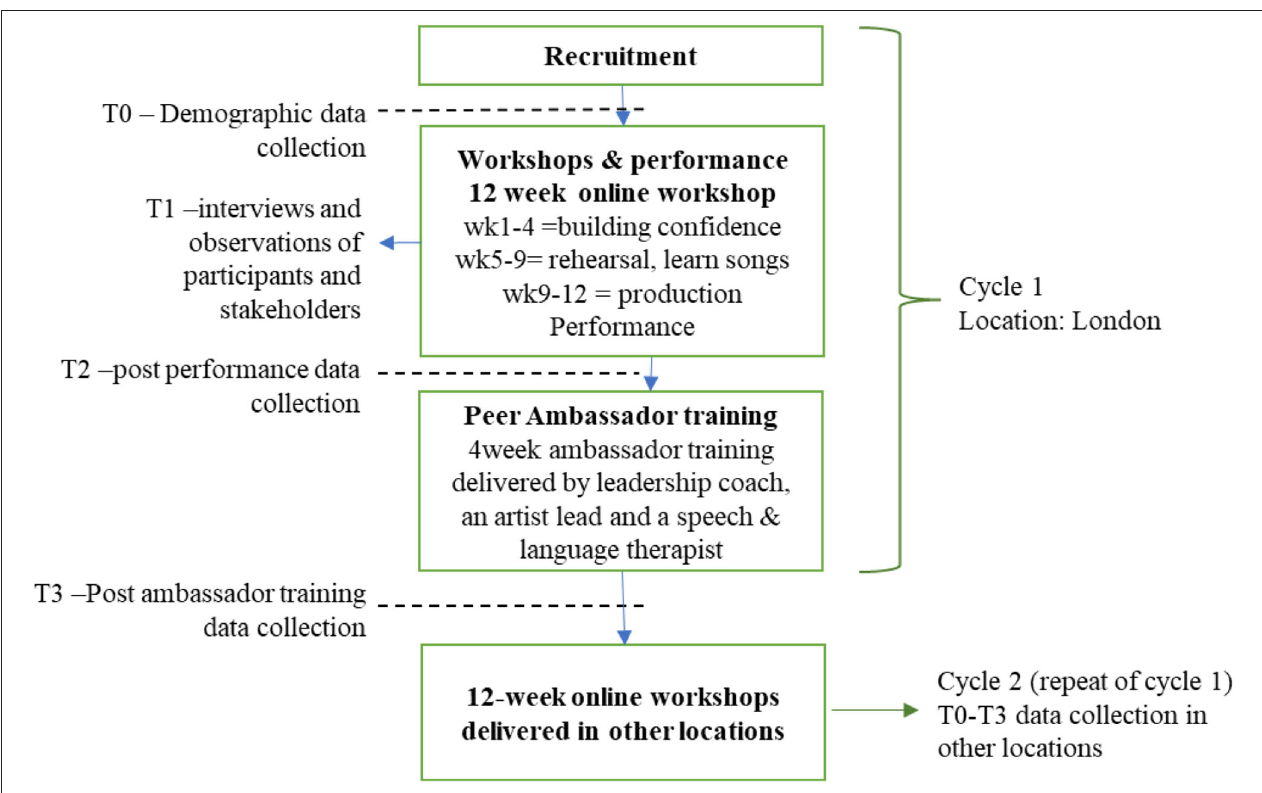
FIGURE 1 | Brain Waves Flowchart (cycles 1 and 2). Data collection timepoints at T0, T1, T2 and T3 of both cycles. First cycle (recruitment, workshops and performance and peer ambassador training will be conducted in London); cycle 2 will be conducted in other locations and the same data collection schedule will take